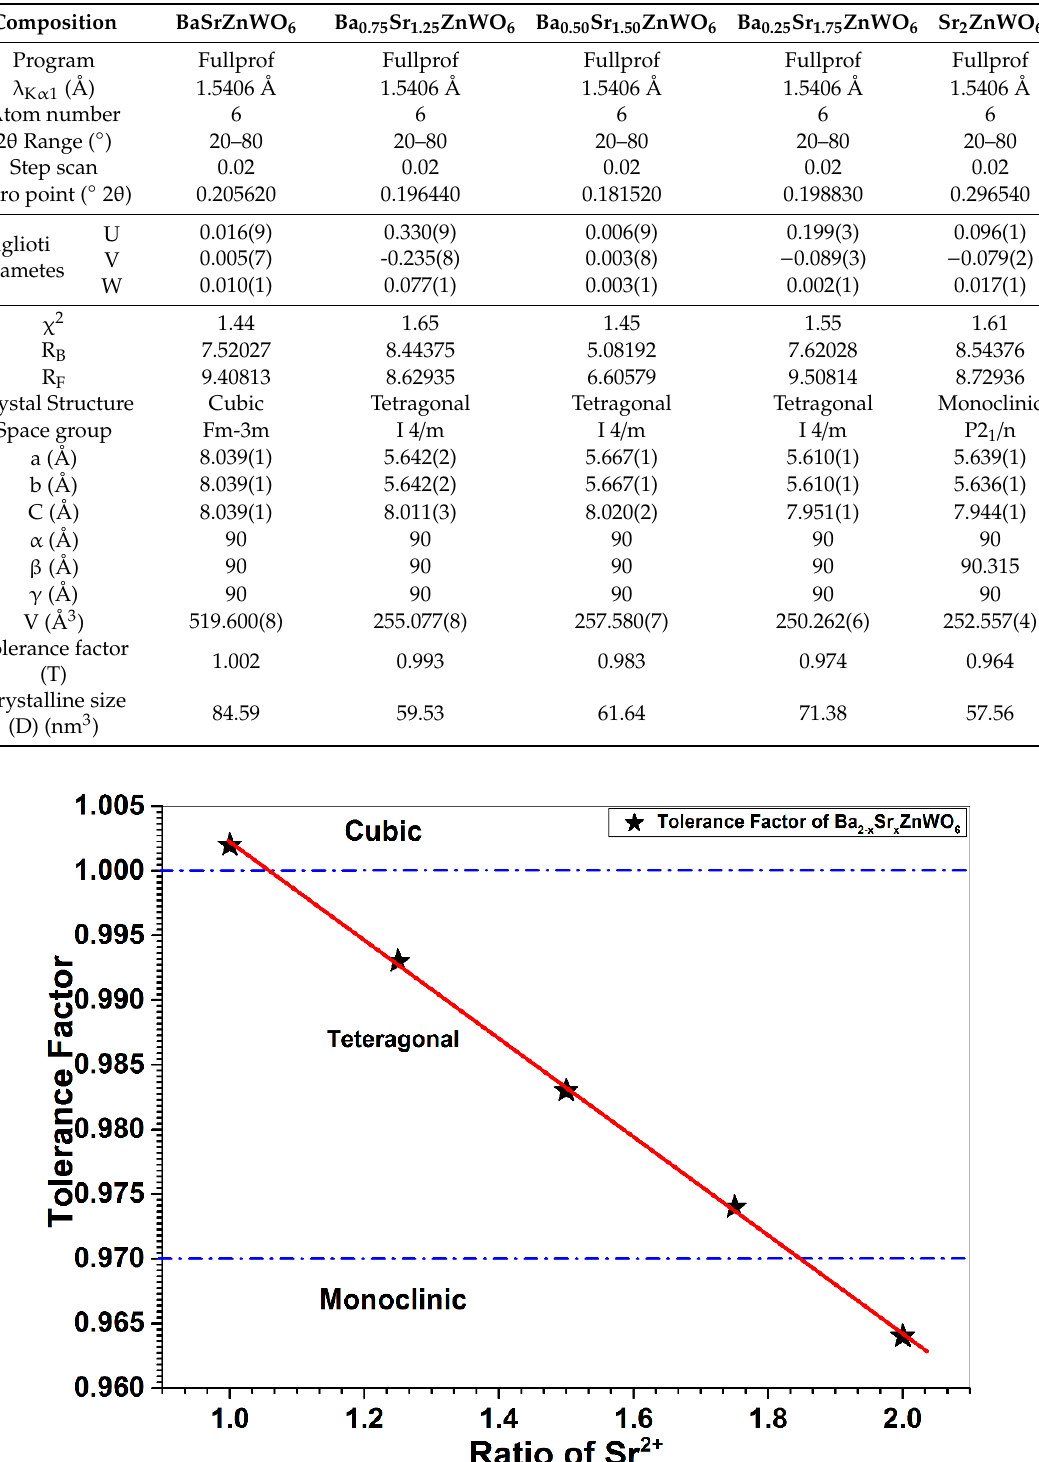
Figure 3. The relationship between the tolerance factor and the ratio of substitution.